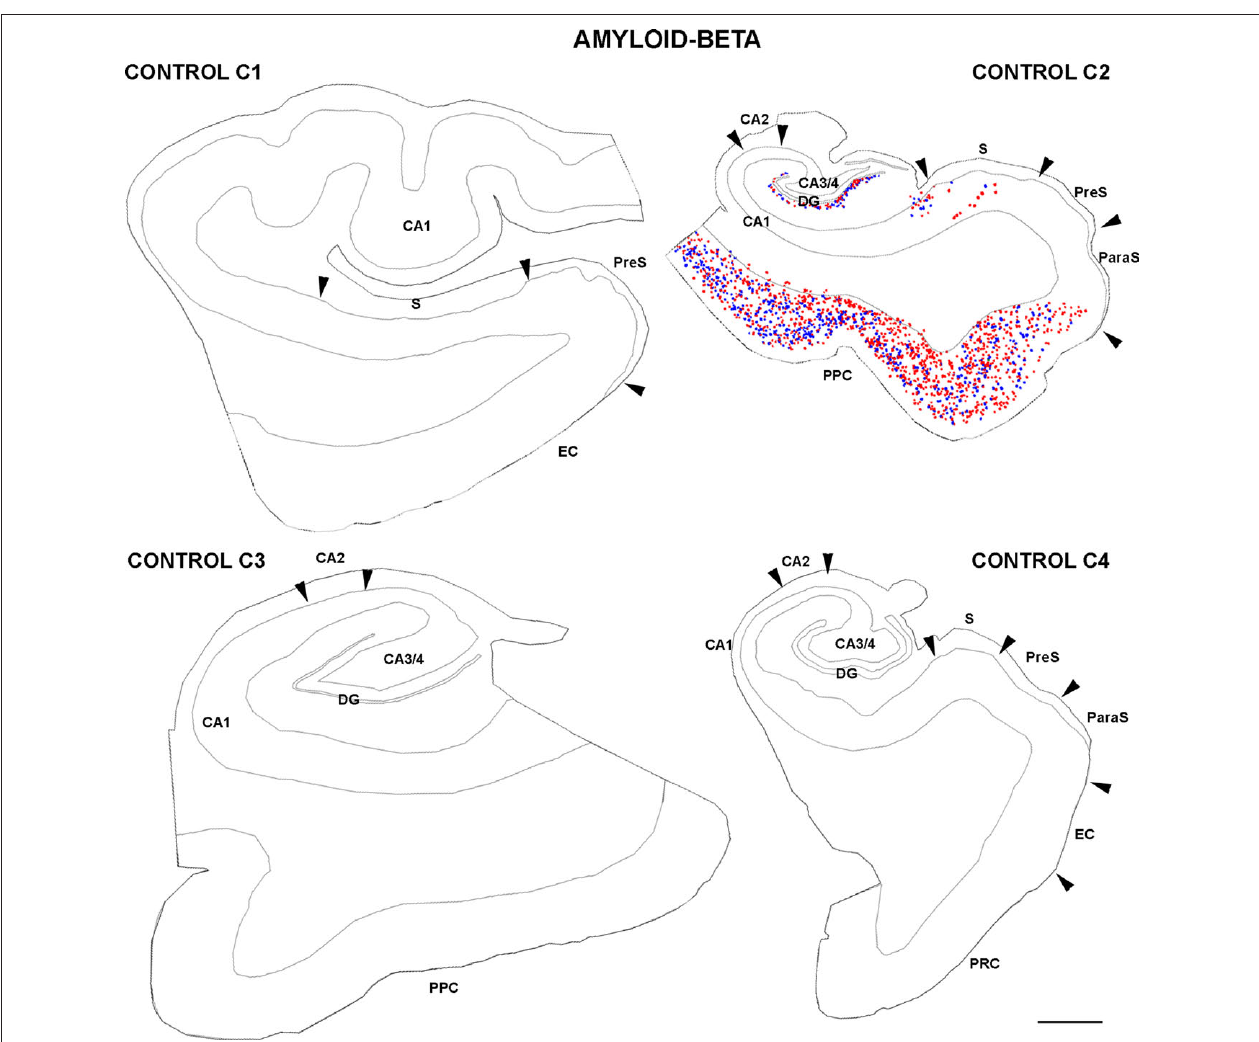
FiGure 7 | Graphs showing the percentage of PHF-tau-ir neurons displaying type i and ii staining in the hippocampal formation and adjacent cortex of control and AD patients. Dentate gyrus (DG); CA3/4, CA2, CA1 proximal